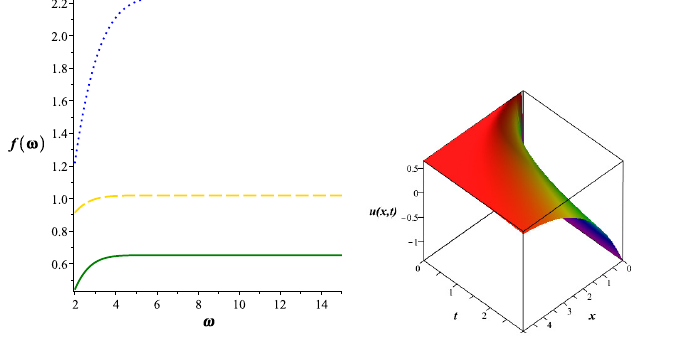
Figure 2. The self-similar solution of the KPZ equation without any noise term for c 1 = c 2 = 1. Solid line is for λ = ν = 1, dashed line is for ν = 1 and λ = 2 and the dotted line represents ν = 2 and λ = 1.